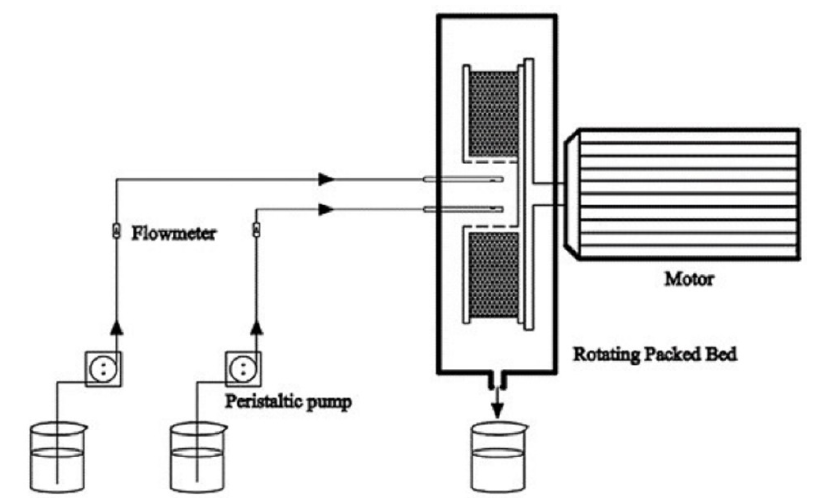
Figure 1. Schematic diagram of the preparation procedure.